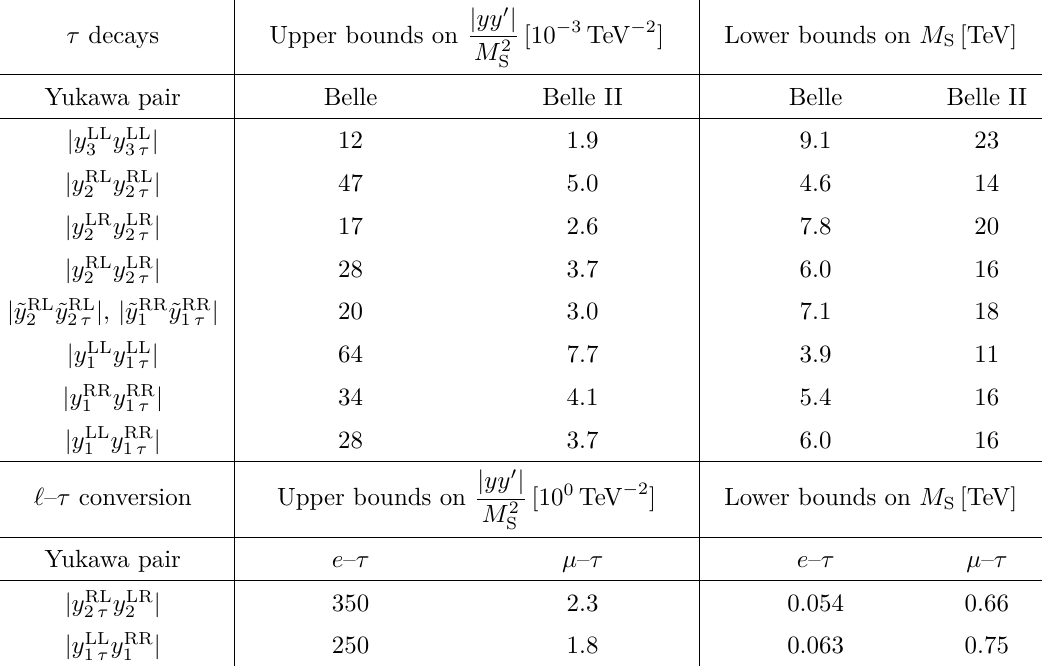
; these numbers, of S = M ), considering | yy 0 | ≈ 1 . The CLFV S